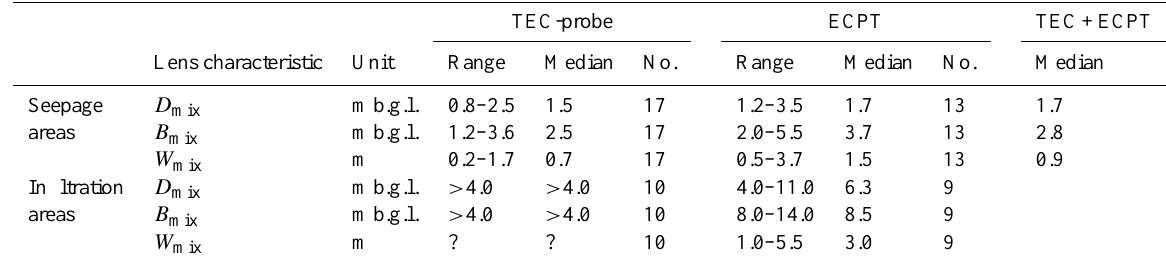
Table 3. Summary of lens characteristics in seepage and infiltration areas derived from TEC-probe and ECPT measurements. TEC-probe ECPT TEC+ECPT Lens characteristic Unit Range Median No. Range Median No. Median Seepage D mix mb.g.l. 0.8–2.5 areas B mix mb.g.l. m Infiltration D mix mb.g.l. > 4.0 areas B mix